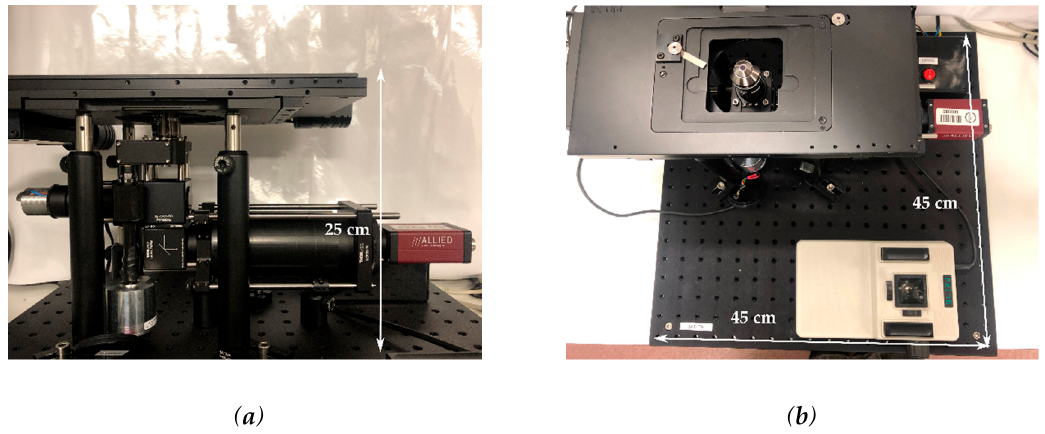
Figure 3. Final set up of the microscope; ( a ) lateral view and ( b ) top view.